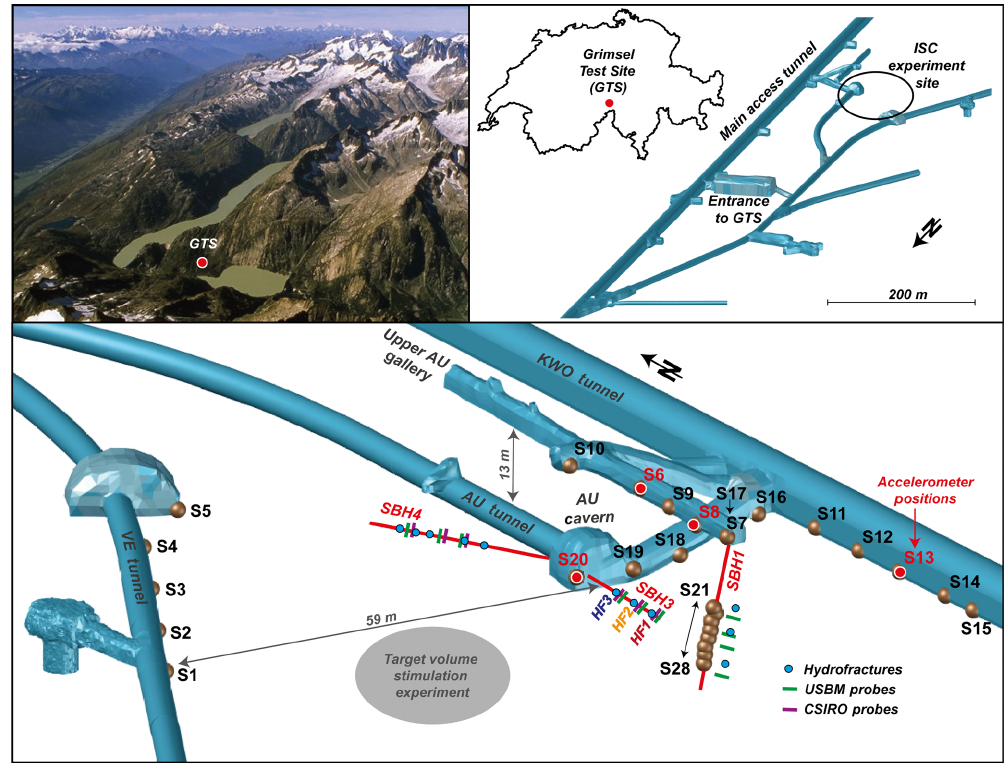
Figure 1. The study site is located in the Bernese Alps in southern Switzerland (photo from www.grimselstrom.ch/elektrische-energie/ kraftwerke-und-stauseen) and consists of a network of tunnels, with the ISC experiment site located between two tunnels. The stress char- acterization survey used three boreholes (SBH-1, SBH-3 and SBH-4) in which overcoring (using USBM and CSIRO probes) and hydraulic fracturing were performed. S1–S28 mark the seismic